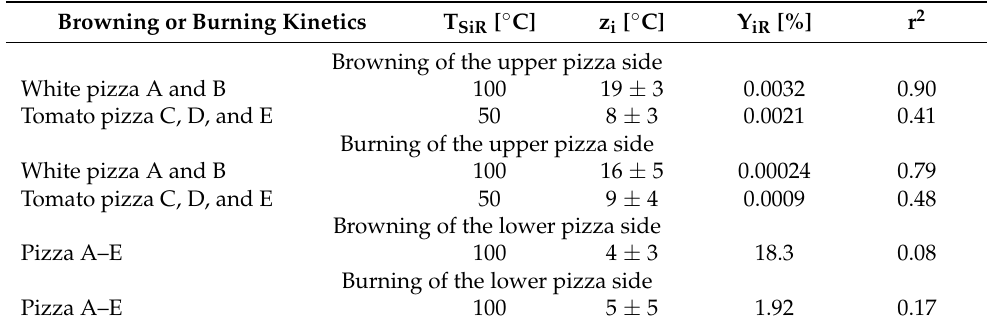
Table 4. Least squares estimate of the empirical coefficients (z i , T SiR and Y iR ) of Equation (2), as referred to the browned and blackened degrees of different pizza samples undergoing baking in a wood-fired oven, and corresponding coefficients of determinations (r 2